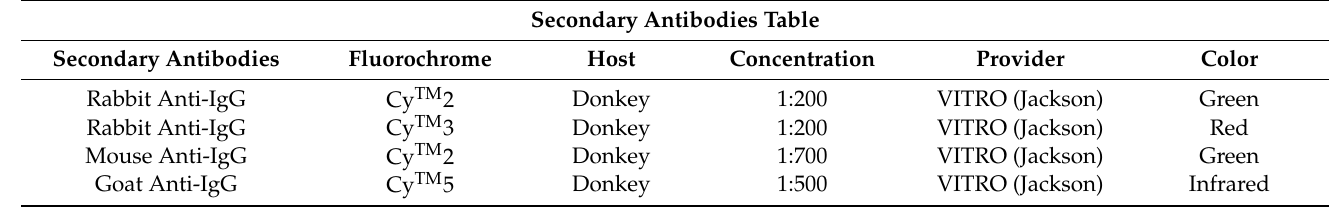
Table 2. Secondary antibodies for the detection of the different primary antibodies used in immuno- histological